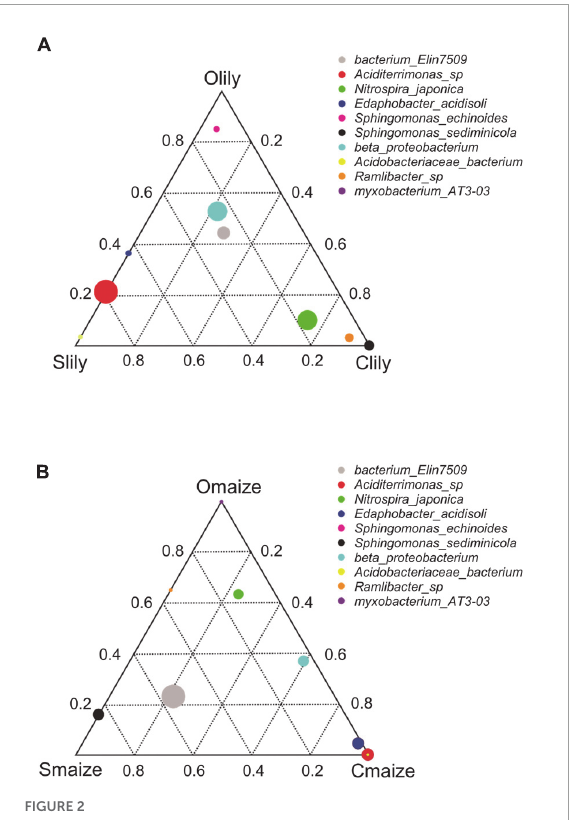
FIGURE2 Cambrian soil shows more flexible bacteria community remodeling compared to Ordovician and Silurian soils. (A) Ternary plot of the top 10 abundant genera of the tiger lily rhizosphere across different soil types. n = 4 biological replicates. (B) Ternary plot of the top 10 abundant genera in the maize rhizosphere across different soil types. n = 4 biological replicates. Different dominant species of three samples at genus level. Vertex means samples. Circles represent species, and the relative abundance of each species is indicated by the size of the circle. The distance of the circles to vertexes presents the relative content of species in the sample. ( Supplementary Figure 1C ). Similarly, the Shannon index ( Figure 1C ) also supports the finding that the rhizosphere microbiome in Clily is more dynamic compared with other